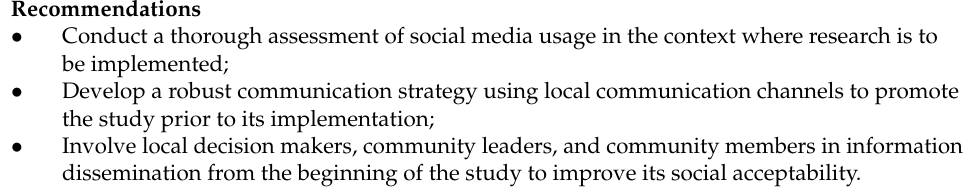
Table 1. Recommendations for global health researchers and practitioners.